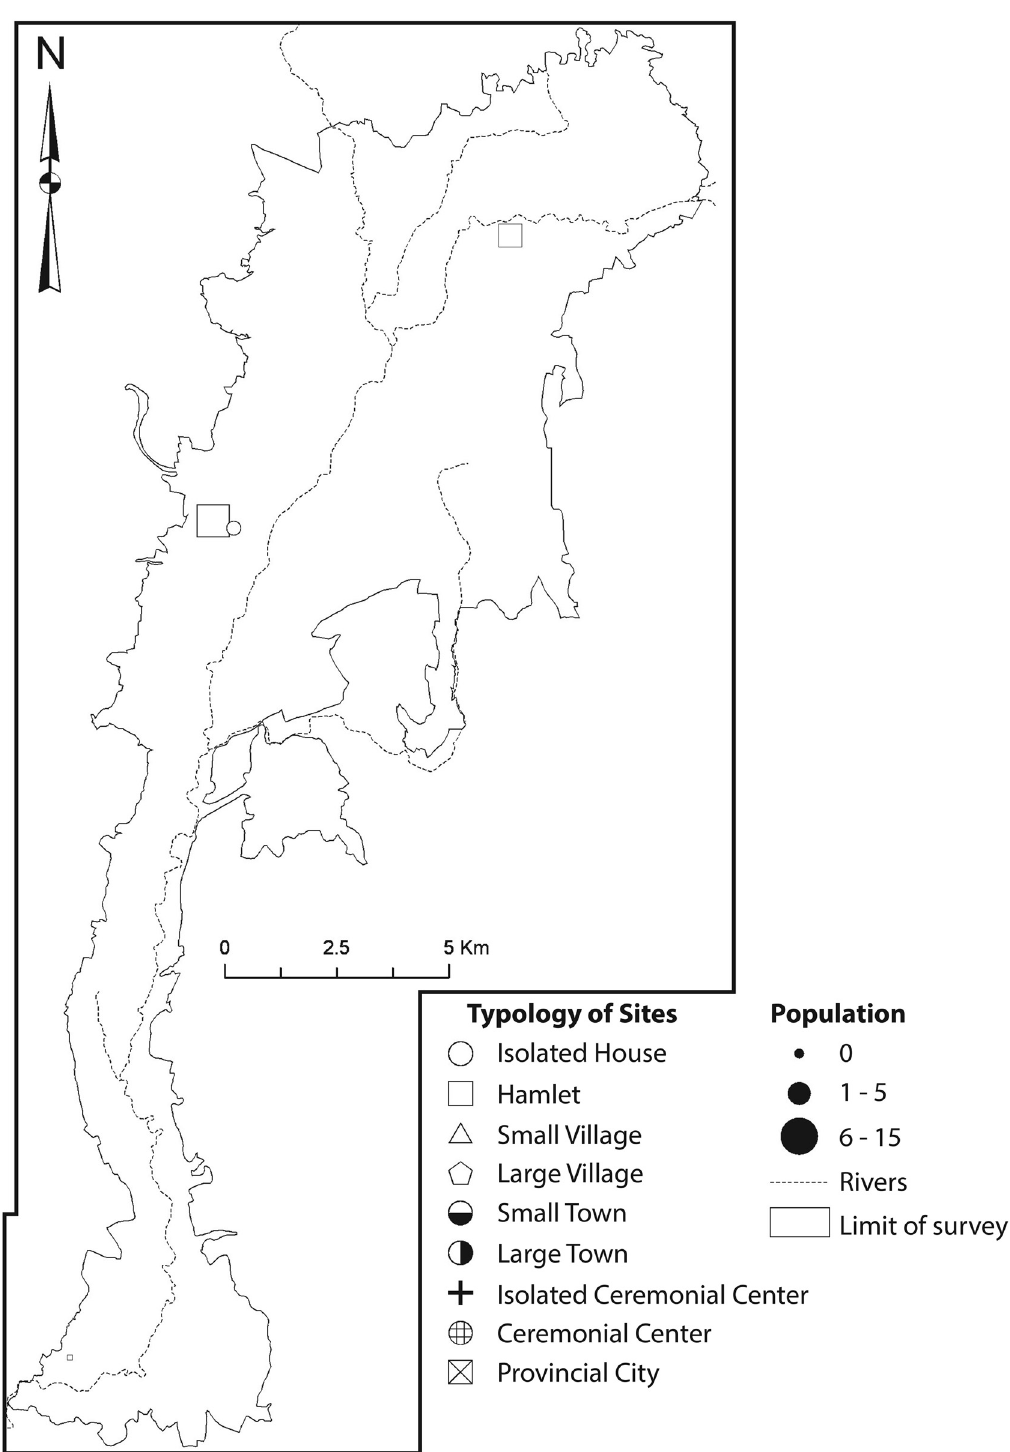
Figure 4: Settlement patterns of the Early Formative